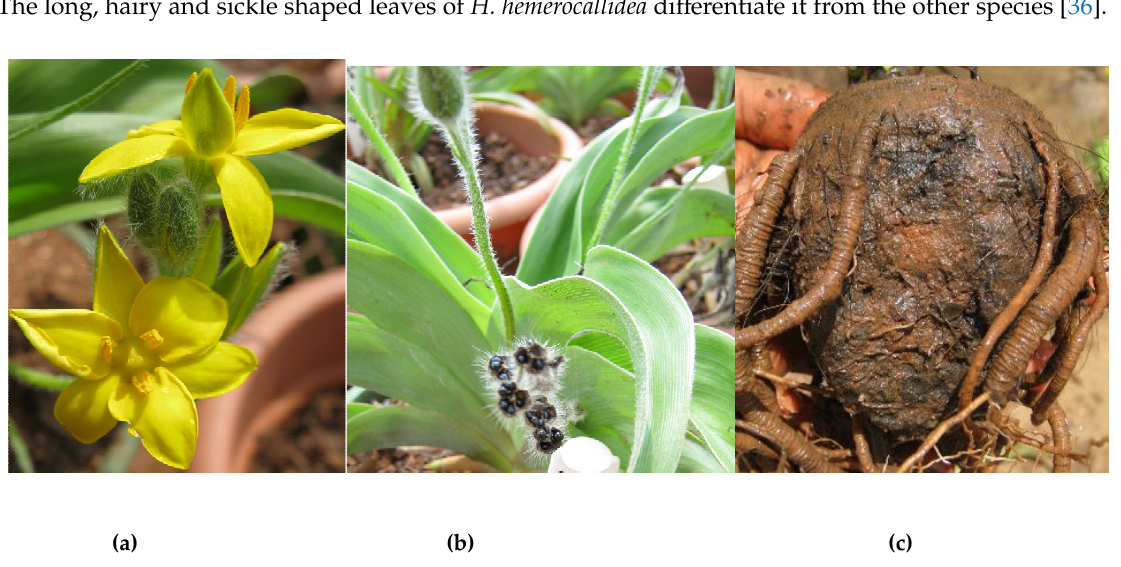
Figure 1. The yellow flowers ( a ), hairy leaves and black seeds ( b ) of Hypoxis hemerocallidea and its corm ( c ).